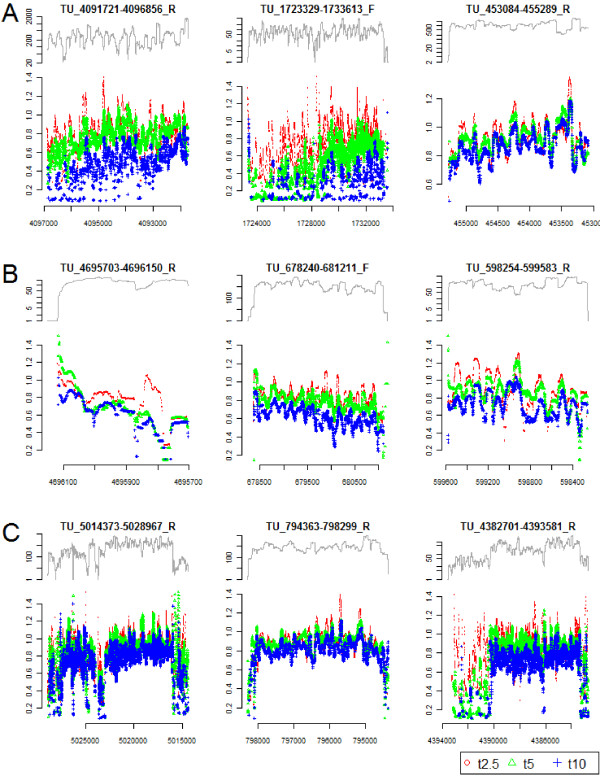
Representative examples of mRNA decay patterns for selected operons from B. cereus ATCC 10897. For each operon, the upper graph displays the coverage at t0 plotted from the start to the end of the operon, while the lower graph shows, for each single nucleotide position, the log2 ratio of the sequence coverage at different time-points following rifampicin addition (red, t2.5, 2.5 minutes; green, t5, 5 minutes; blue, t10, 10 minutes), relative to the sequence coverage at t0. (a) Operons demonstrating examples of 5' to 3' direction of mRNA decay, that is, the sequence coverage for bases near the 5' end of each ORF in the mRNA drops faster than for bases at the 3' end of ORFs. (b) Operons demonstrating examples of 3' to 5' direction of mRNA decay. The seemingly anomalous pattern for the 2.5 minute or 5 minute time-points in the 5' end of the TU_4695703-4696150_R transcript (green graph, leftmost panel) may be due to technical noise. (c) Operons showing various complex types of decay patterns, where specific blocks of the polycistronic mRNA are degraded faster, or show a pattern of faster decay at both 5' and 3' ends relative to other parts of the mRNA.